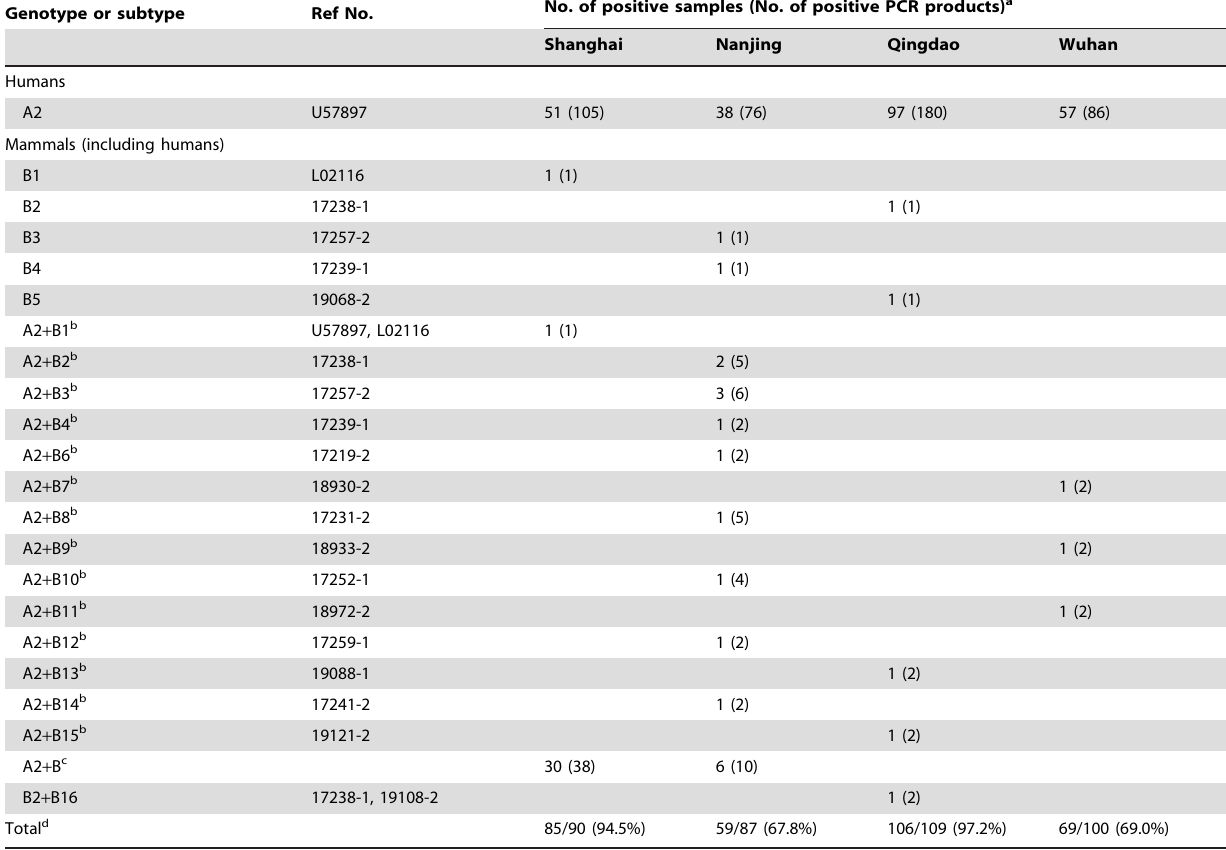
a All data on specific genotypes and subtypes are based on sequence analysis. b Different sequencing results in different PCR replicate analyses of each sample. B2–B16 are new subtypes identified in this study. c Based on the occurrence of underlying peaks in DNA sequencing trace files; the subtype identity of assemblage B could not be established under such a circumstance. d No. of positive samples/No. of samples (positivity in percentage) based on PCR analysis of the tpi gene.